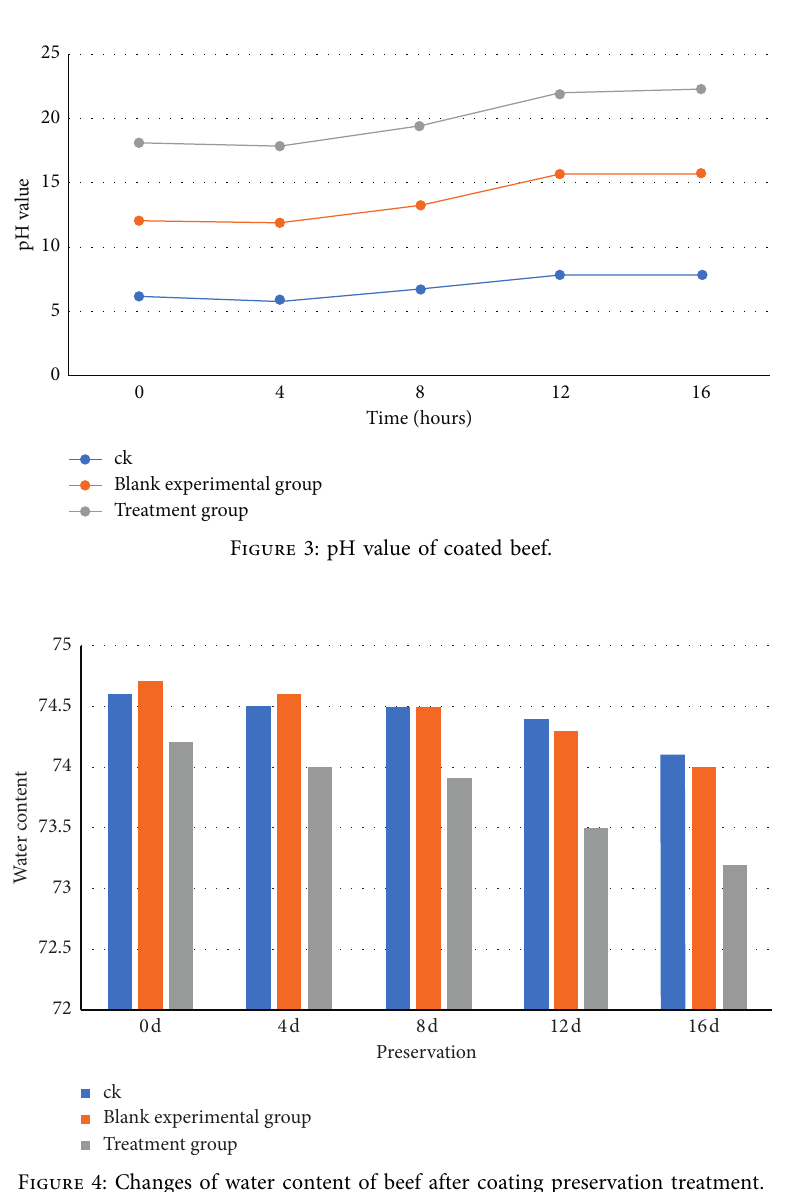
Figure 4: Changes of water content of beef after coating preservation